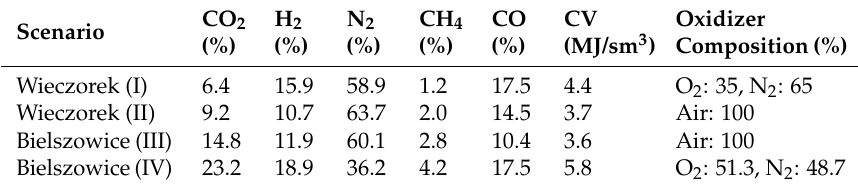
Table 18. Synthesis gas compositions and calorific values investigated in one-at-a-time sensitivity analyses; values given in % by volume; data derived from Sta´nczyk et al. [8,10]; CVs